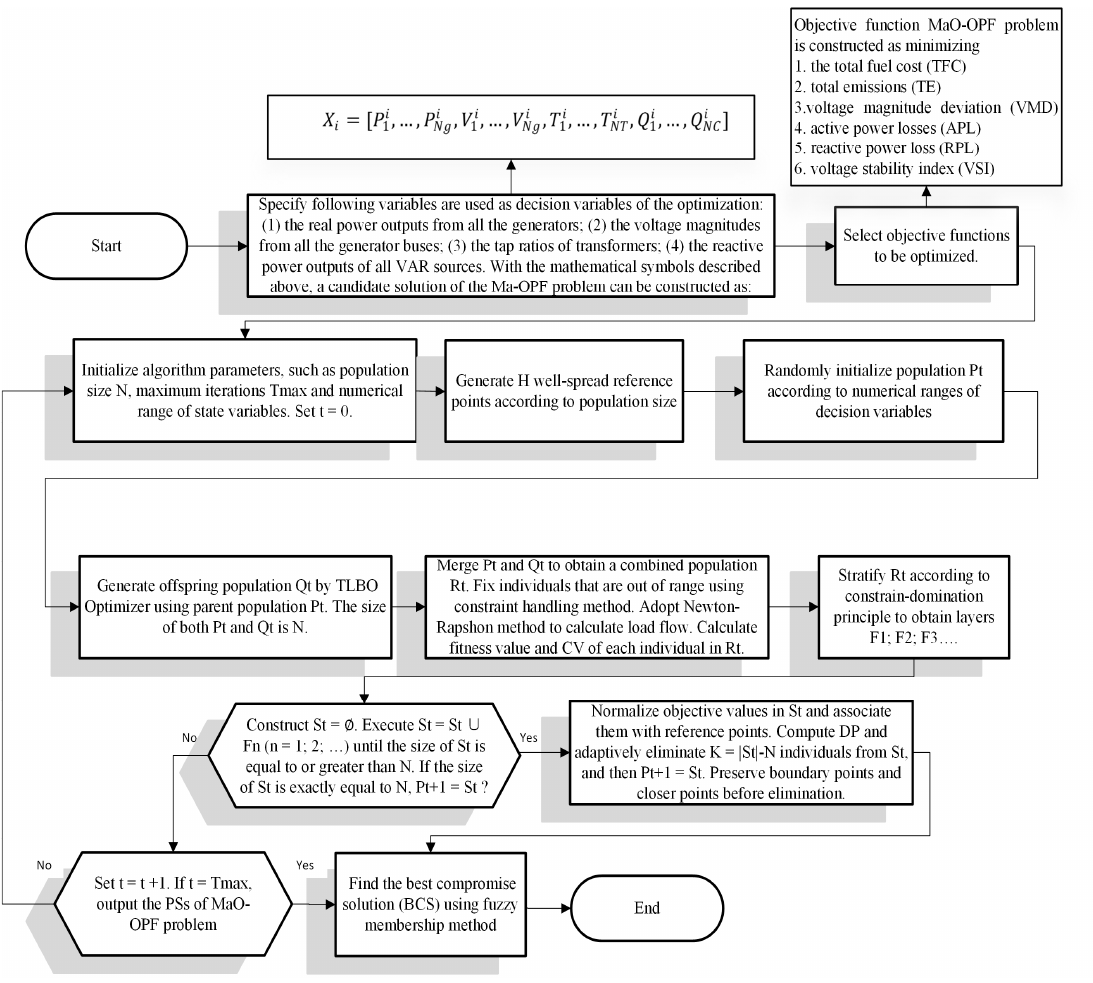
Fig. 6. Flow chart for solving MaO-OPF problem using MaOTLBO